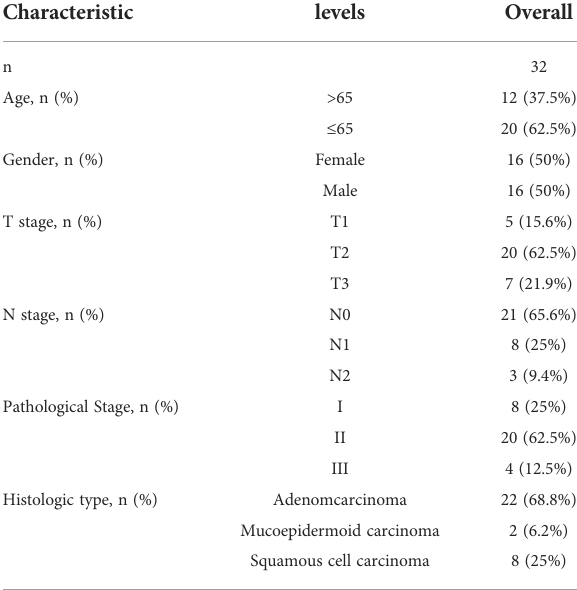
TABLE 1 Basic characteristics of enrolled clinical